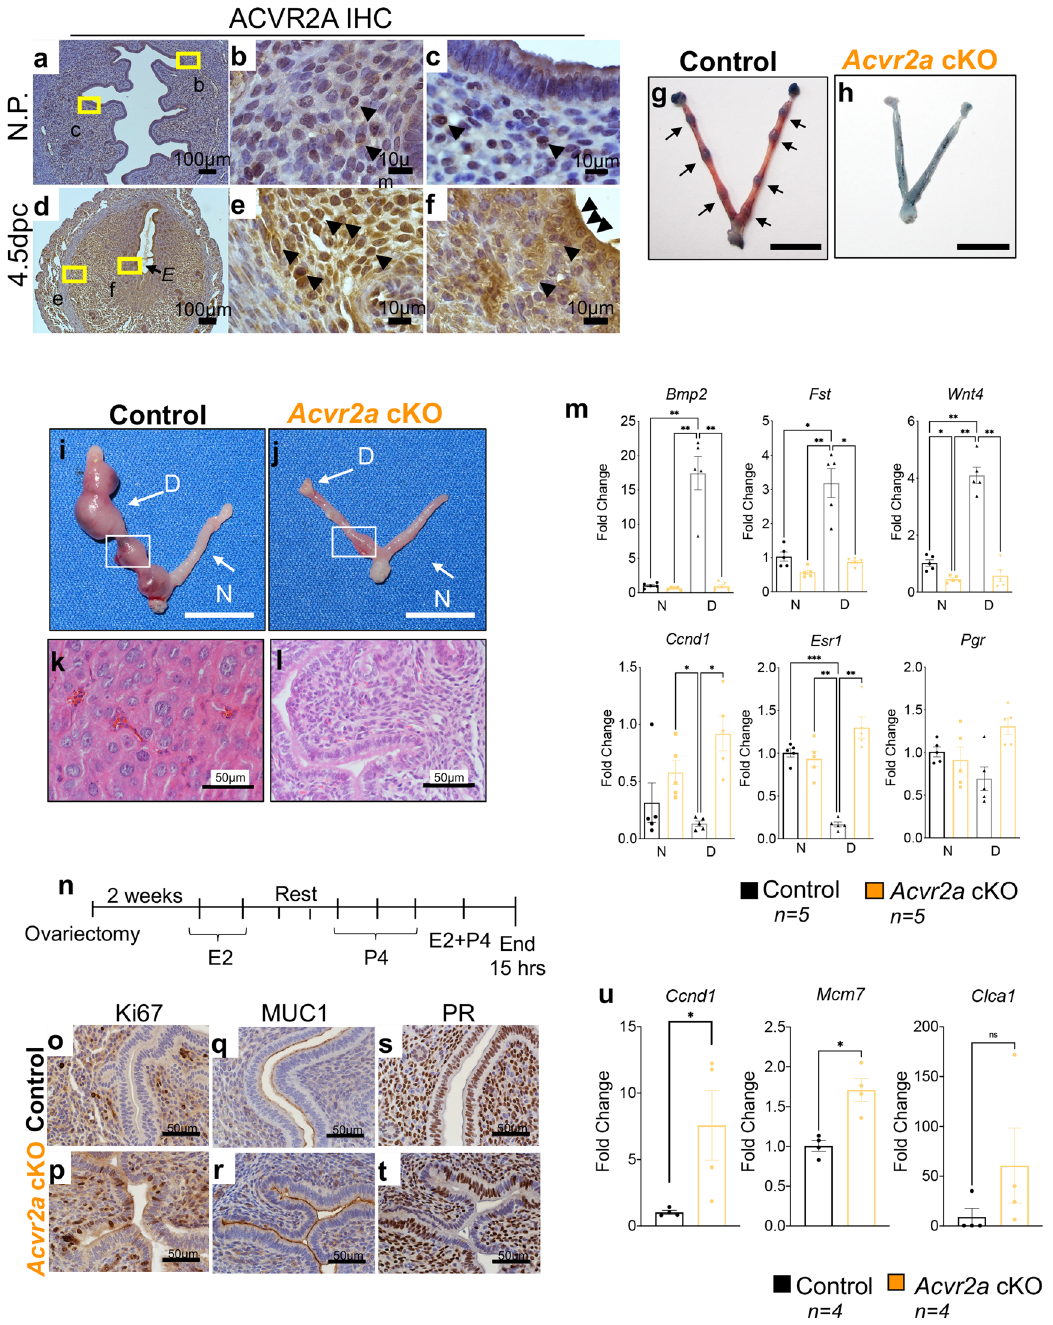
Fig. 5 Acvr2a cKO mice are infertile and show defective endometrial receptivity. a – f ACVR2A immunohistochemistry (IHC) was performed in mouse uterine cross-sections in non-pregnant ( a – c ) and 4.5 dpc pregnant d – f WT mice. E , denotes embryo; black arrowheads indicate positively-stained cells. g – h Images of 4.5 dpc uteri of control ( g ) and Acvr2a cKO ( h ) mice injected with Chicago Sky Blue dye to visualize implantation sites (denoted by black arrows in g ). Size bar = 1 cm. Decidual response was measured in control ( i ) and Acvr2a cKO ( j ) mice. D , decidual horn; N , non-decidual horn; Size bars = 1 cm. k – l H&E-stained cross-sections of the decidualized horns of control ( k ) and Acvr2a cKO ( l ) mice. m qPCR analysis of decidual-related genes, Bmp2 ( p = 0.002 ), Fst ( p = 0.002), Wnt4 ( p < 0.0001), Ccnd1 ( p = 0.03) , Esr1 ( p = 0.0007) and Pgr ( p = 0.529) in the non-decidual ( N ) and decidualized ( D ) tissues of control (black bars, n = 5) and Acvr2a cKO (orange bars, n = 5) mice. Histograms represent mean ± SEM. Analyzed by one-way ANOVA with Tukey ’ s multiple comparisons post-test, asterisks above each bar represent statistically signi fi cant difference, * p < 0.033, ** p < 0.002, *** P < 0.001. n Experimental scheme used to test uterine response to steroid hormones (Pollard experiment). o – t IHC of uterine tissues from control ( o , q , s ) and Acvr2a cKO mice ( p , r , t ), stained with Ki67 ( o , p ), MUC1 ( q , r ), and PR ( s , t ). u qPCR quanti fi cation of Ccnd1 (p = 0.046), Mcm7 (p = 0.004) and Clca3 (p = 0.23) in the uteri of control (black bars, n = 4) and Acvr2a cKO (orange bars, n = 4) mice collected 15 h after 10 ng E2 + 1 mg P4 administration. Images represent experiments performed in at least three subjects of each genotype. Histograms u represent mean ±SEM. Paired, two-tailed t test, * p < 0.033, ** p < 0.002, *** P < 0.001.